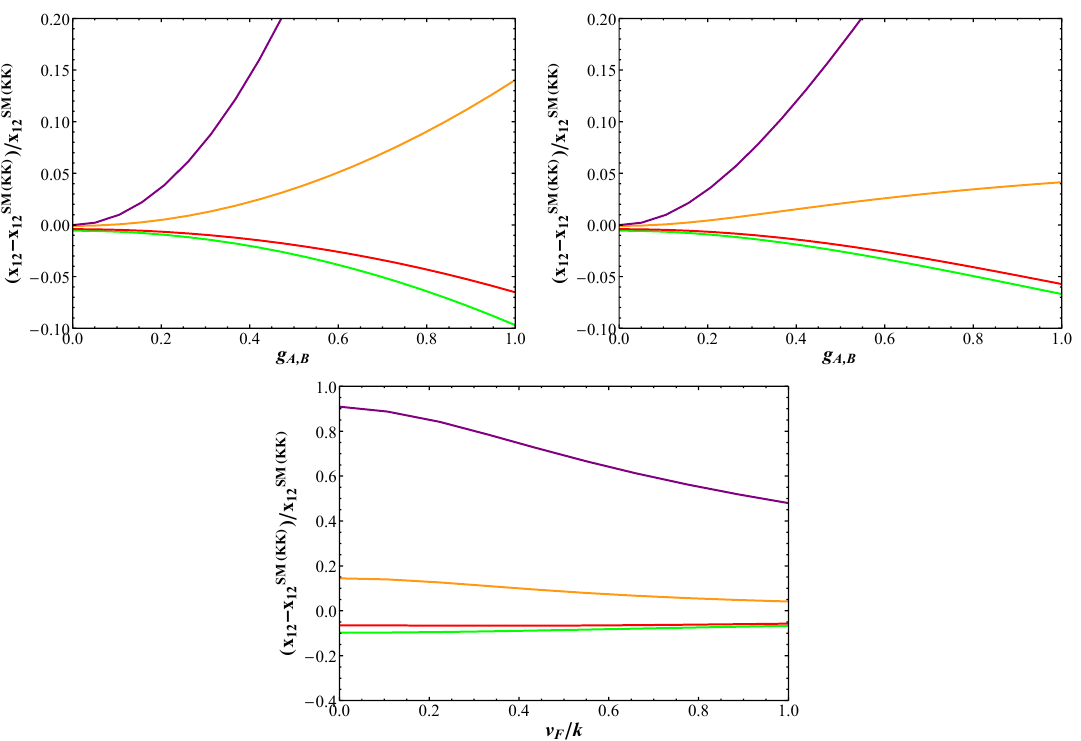
Figure 14. The dependence of the parameter x 12 on g A;B for v F = 0 : 1 k (top left), on g A;B for v F = k (top right), and on v F for g A;B = 1 : 0 (bottom), for several di(cid:11)erent points in our sample parameter